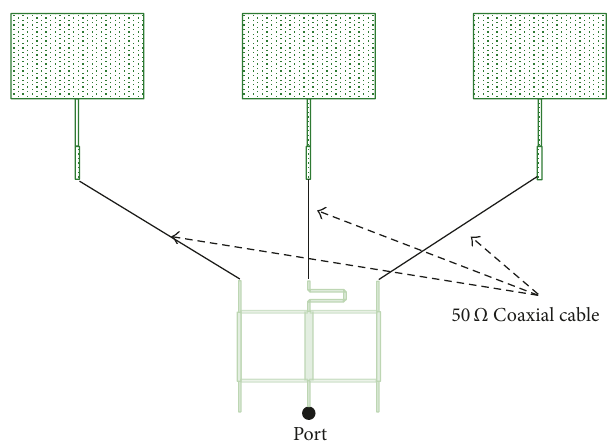
Figure 5: The combination 1 × 3 array antenna and coupler.